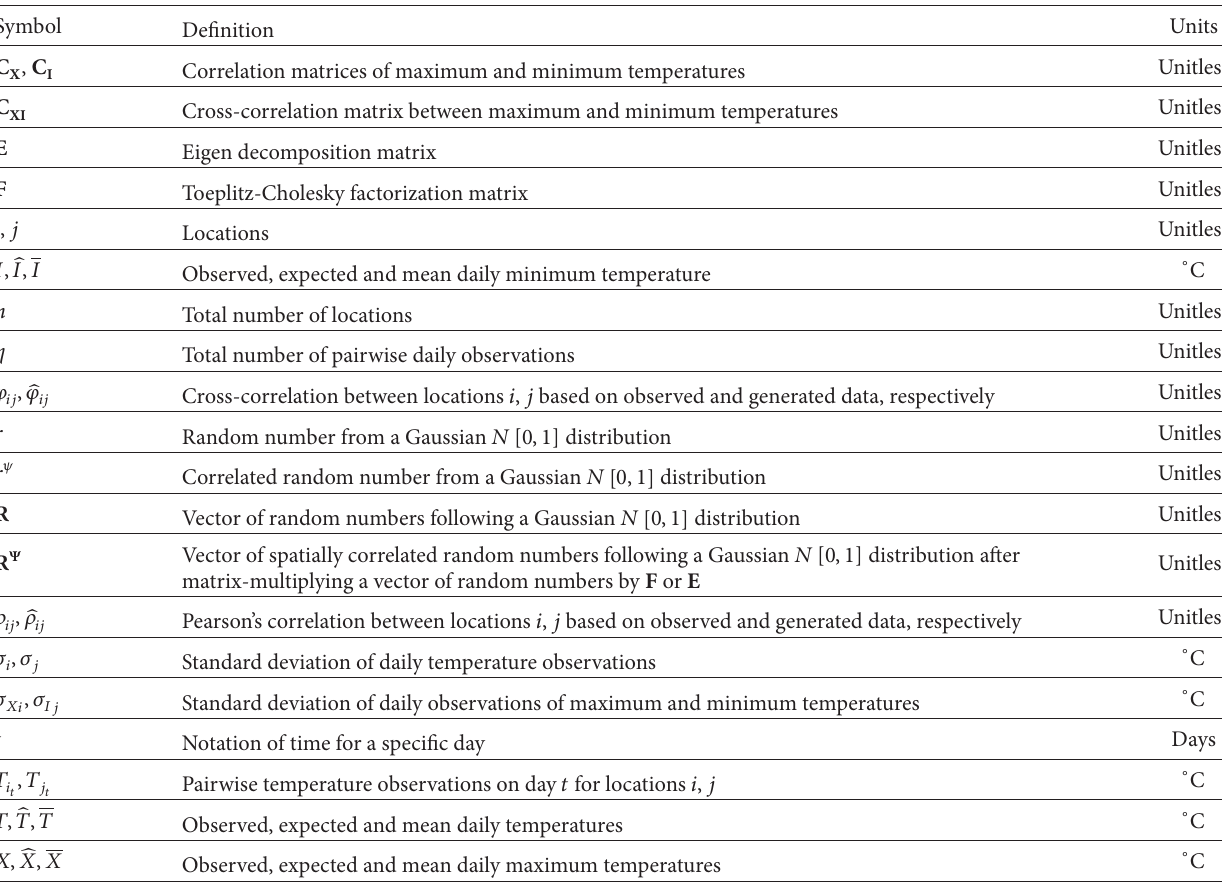
Table 2: Variable description.